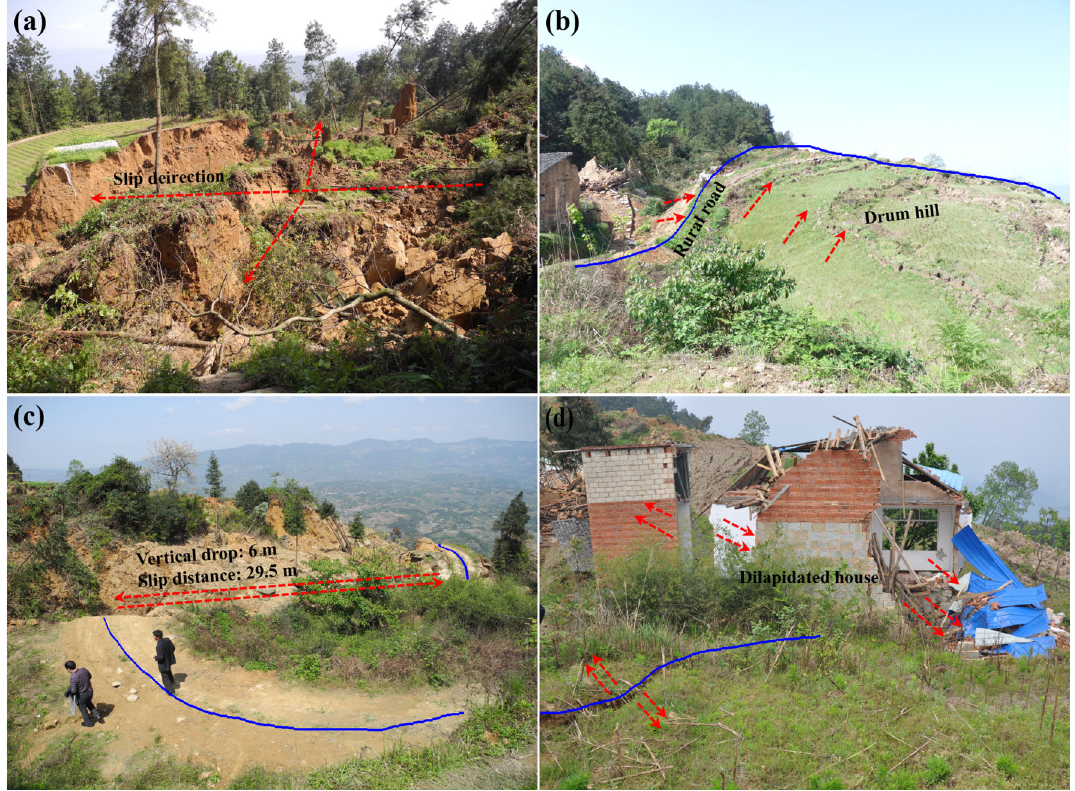
Fig. 3 Photographs showing the characteristics of landslide defor- mation at the 2013 Sunjia landslide site. a The tensile groove; b The drum hill; c The damaged rural road; d The dilapidated houses. The red dashed lines and arrows indicate the direction of surface